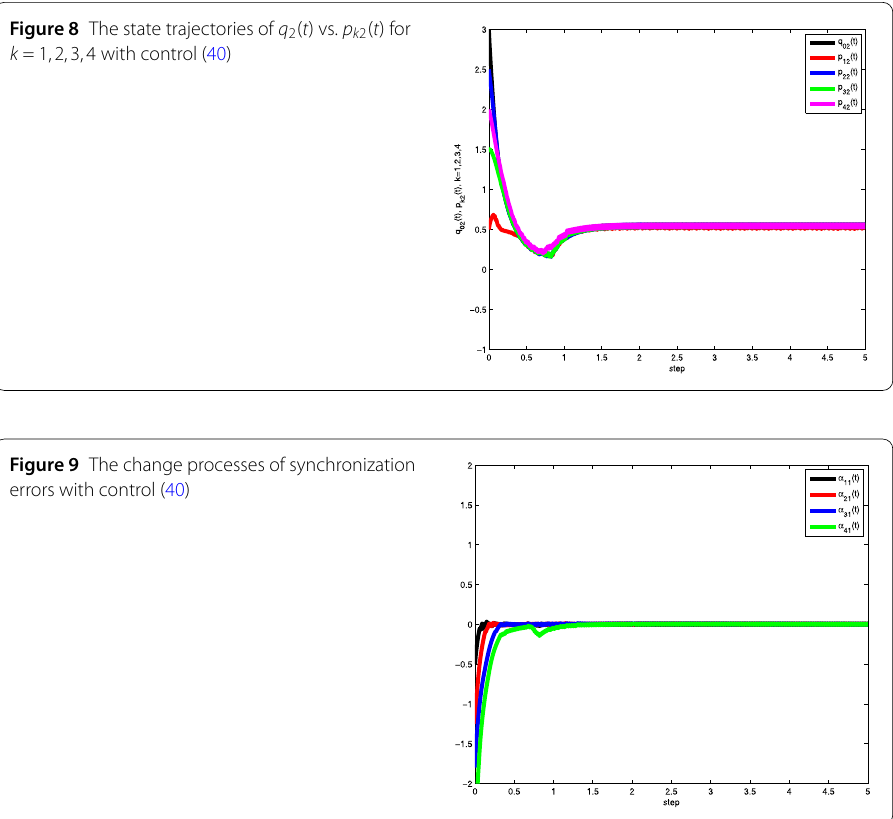
Figure 9 The change processes of synchronization errors with control